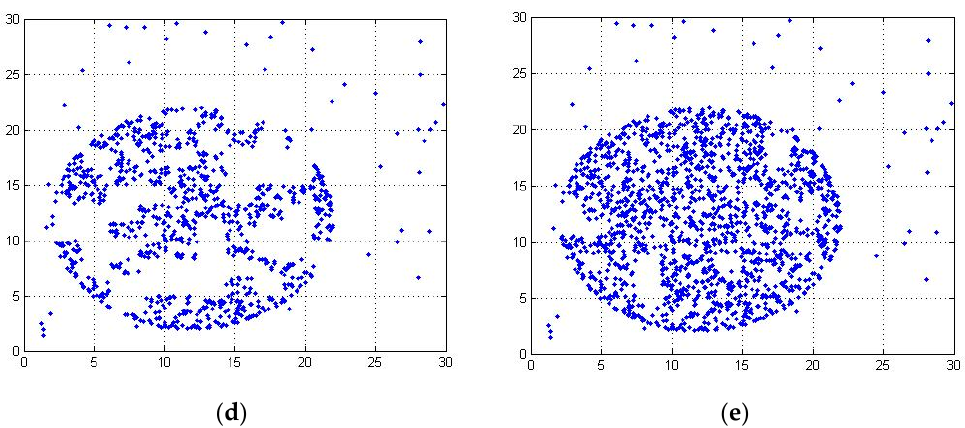
Figure 11. Experimental comparison of the effectiveness of our DOM method: ( a ) Dataset distribution with |N| = 2073; ( b ) dataset distribution after being divided by P,T (|N| = 81); ( c ) dataset distribution after being divided by P,T (|N| = 431); ( d ) dataset distribution after being divided by P,T (|N| = 1014); ( e ) dataset distribution after being divided by P,T (|N| = 1729).